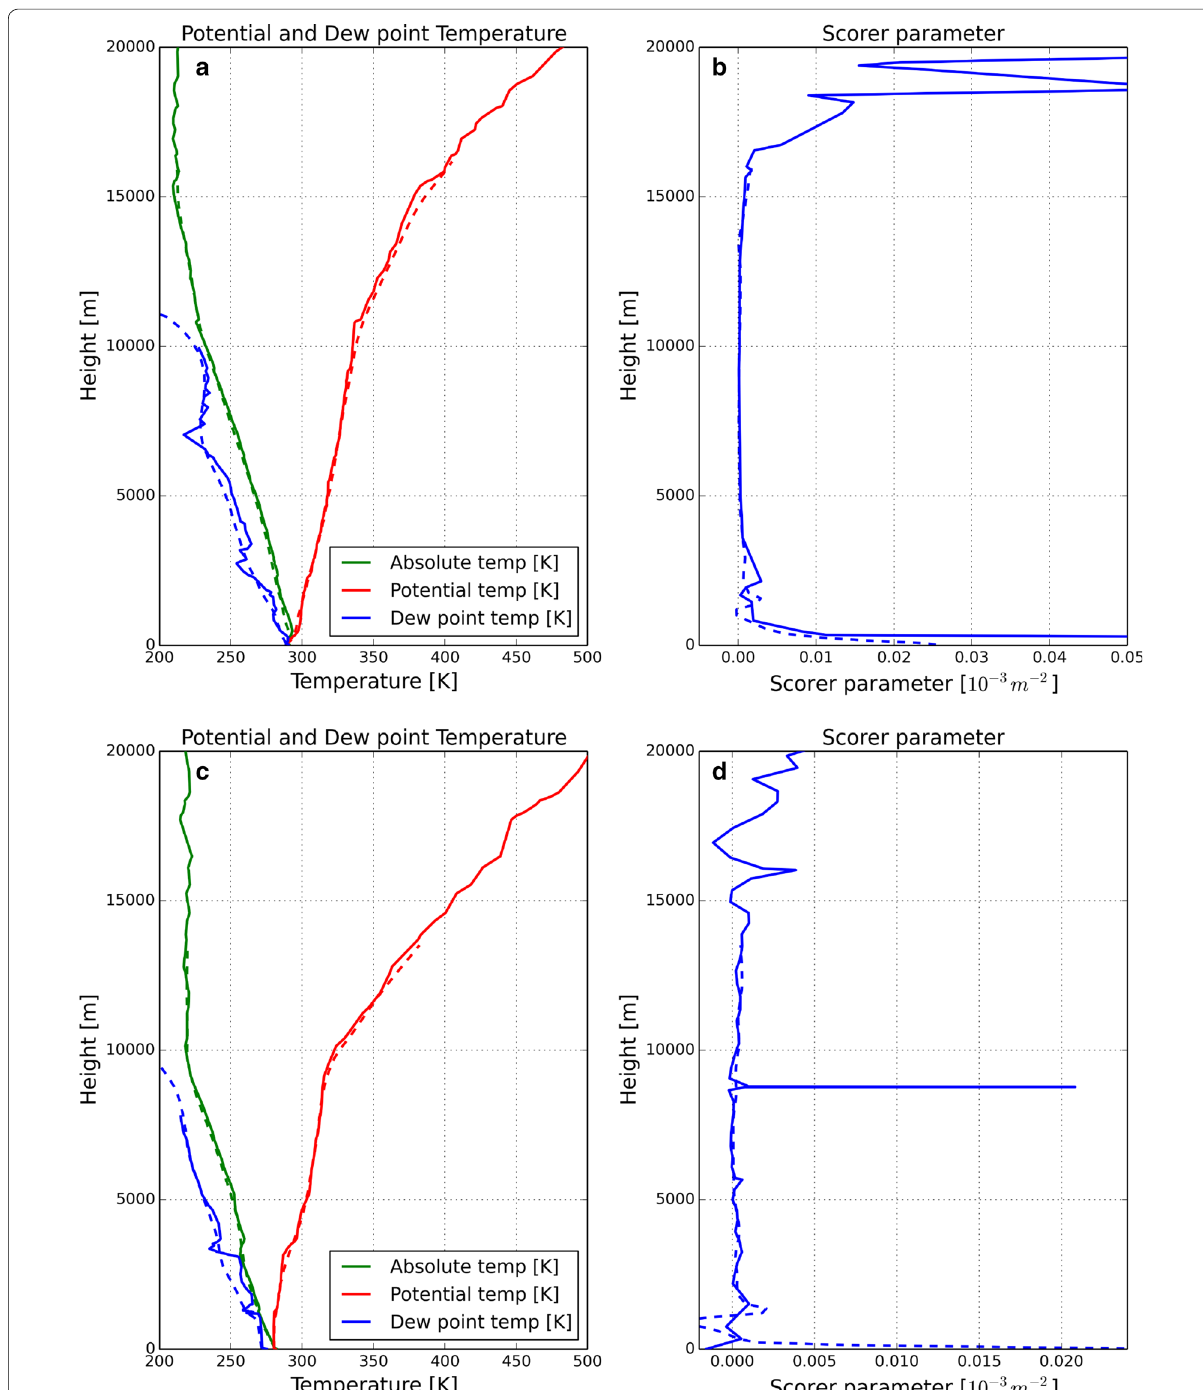
Fig. 3 Radiosonde observed data. Vertical profiles derived by the radiosonde ( solid lines ) and WRF simulation ( dashed lines ) at Kushiro station on 00:00 UTC of September 6, 2014, ( a , b ) and at Akita station on 00:00 UTC of April 30, 2016, ( c , d ). a , c Green , blue and red lines indicate temperature, dew point temperature and potential temperature, respectively. b , d Profiles of the Scorer